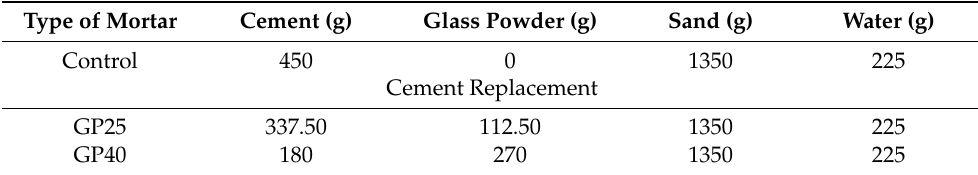
Table 1. Mortar mixtures replacing cement with